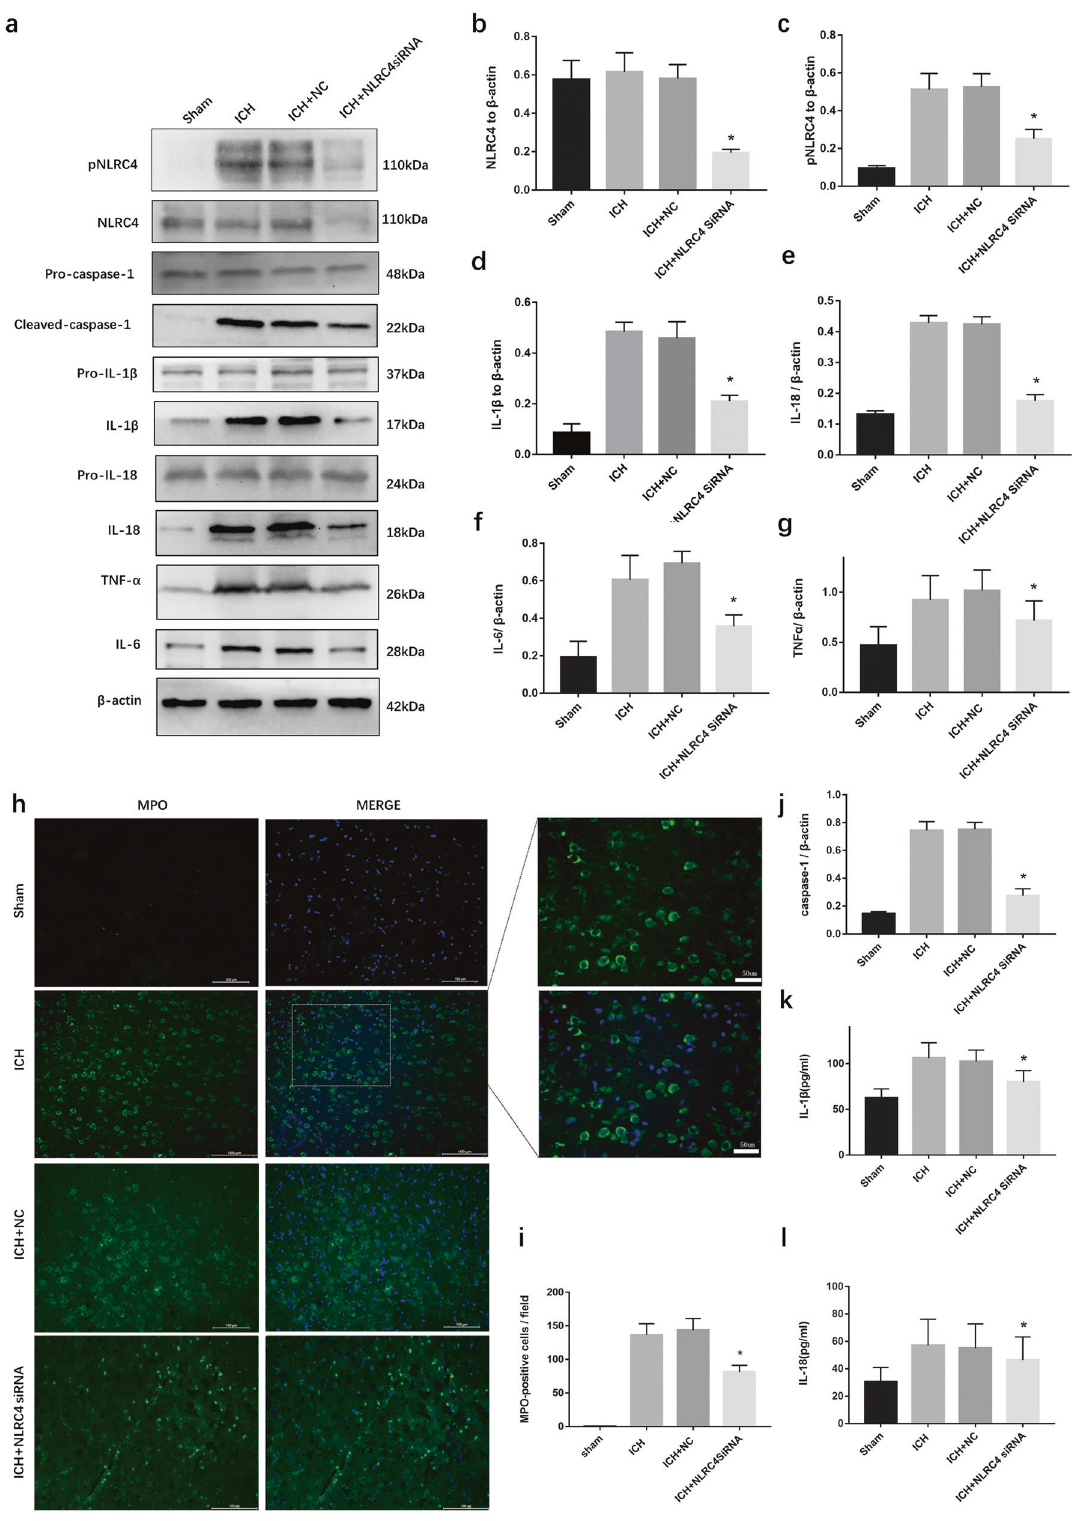
Fig. 4 In fl ammation response were reduced by NLRC4 siRNA after ICH. a – g , j Western blot assay to detect NLRC4, pNLRC4, Pro-IL-1 β , IL-1 β , Pro-caspase-1, caspase-1, Pro-IL-18, IL-18, TNF- α , and IL-6, ( k , l ) ELISA for IL – 18 and IL – 1 β ( h , i ) Immunostaining for MPO-positive cells (×400 and ×200) at peri-hematoma area in sham, ICH, negative control siRNA, and NLRC4 siRNA groups at 72 h after ICH (six rats for each group). * P < 0.05, compared with